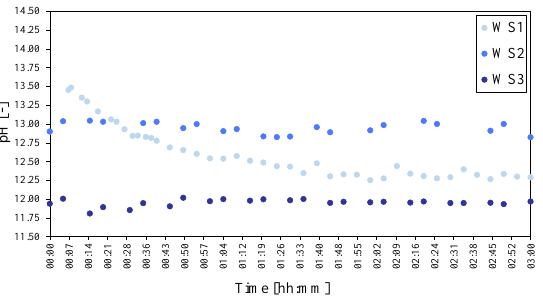
Figure 24. pHs of the water-to-solids ratio series of LDHs WS1 = 70:30, WS2 = 80:20 and WS3 = 90:10. The pH was adjusted to 25 ◦ C to facilitate